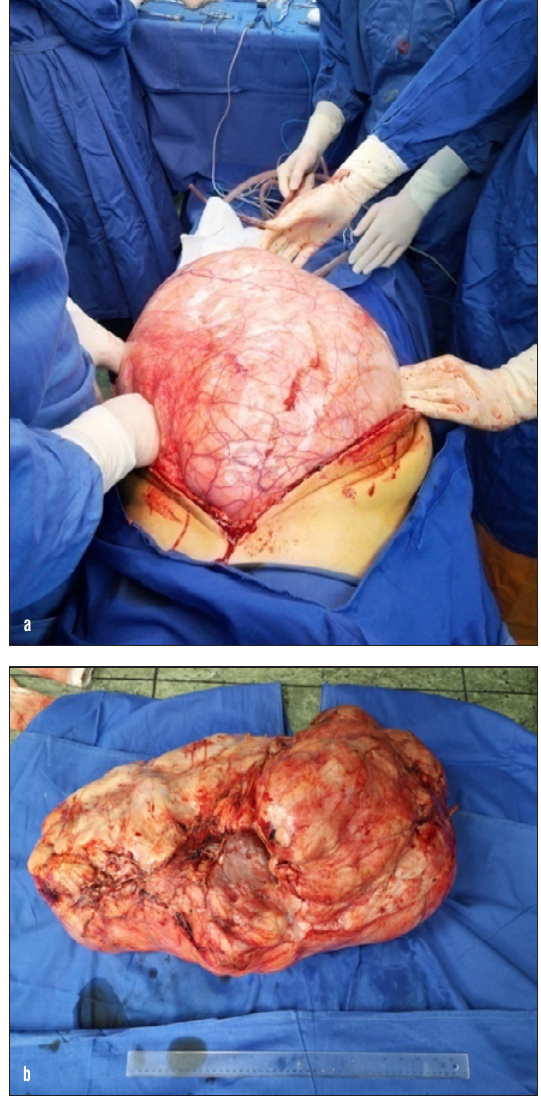
Figure 3. Liposarcoma in situ (a) and macroscopic view of the liposarcoma, 70 x 40 x 25 cm in size